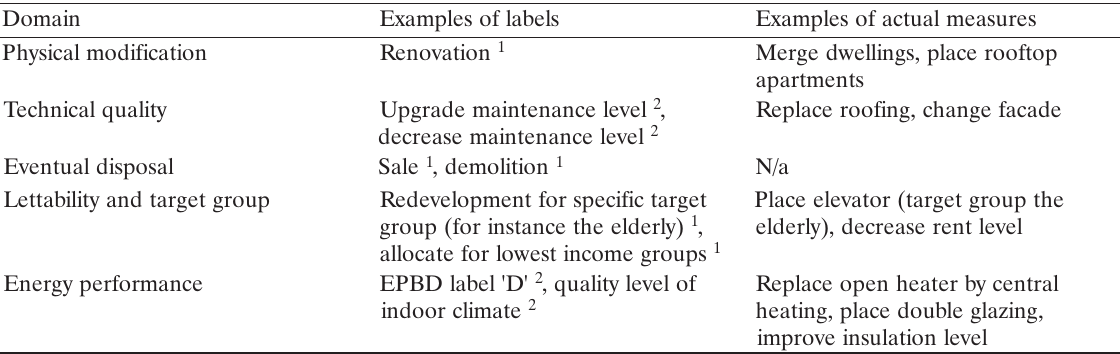
Table 3. Some relevant domains and examples of labels in each domain